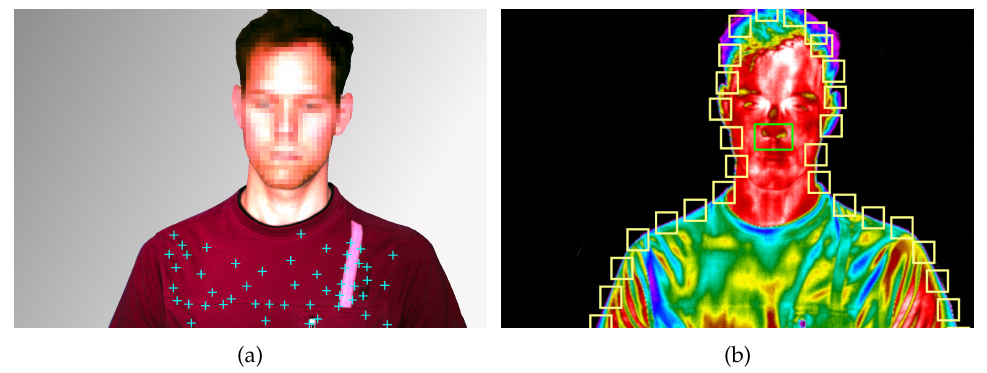
Figure 6. Points and regions of interest for respiratory signal extraction for color and thermal videos: ( a ) Spatially equally distributed minimum eigenvalue feature points on subject’s chest; ( b ) Region of interest for thermal videos at border between subject and background (yellow) and around the subject’s